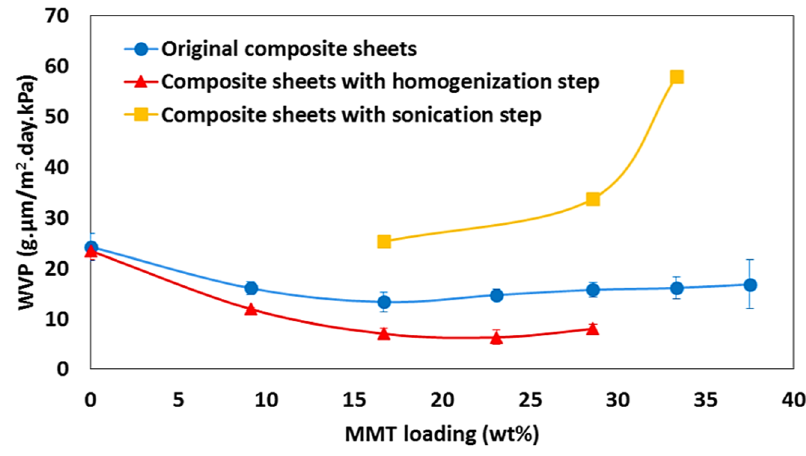
Figure 9. WVP of nanocellulose/MMT nanocomposites. The pristine nanocomposite sheets; nanocomposite sheets with high pressure homogenization step, and sonication step [183]. WVP = water vapor permeability; MMT = montmorillonite. Reproduced with permission from Elsevier.